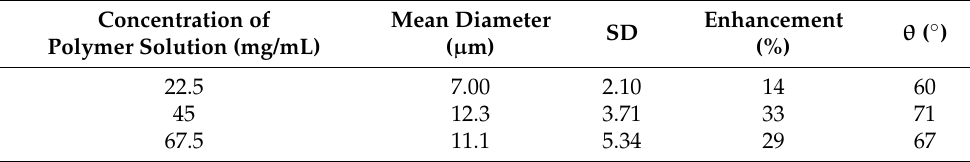
Table 1. Summary of main parameters describing the three micro-sphere PDMS films.